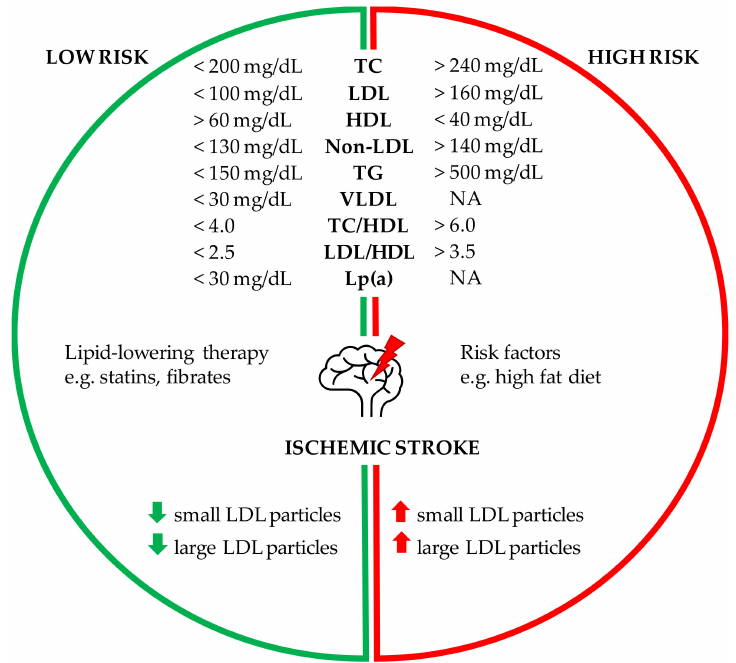
Figure 1. Lipid profile components and the risk of ischemic stroke. The reference values of the specified parameters may vary slightly according to di ff erent diagnostic recommendations. The arrow down indicates a low number of particles; the arrow up indicates a high number of particles. NA—not